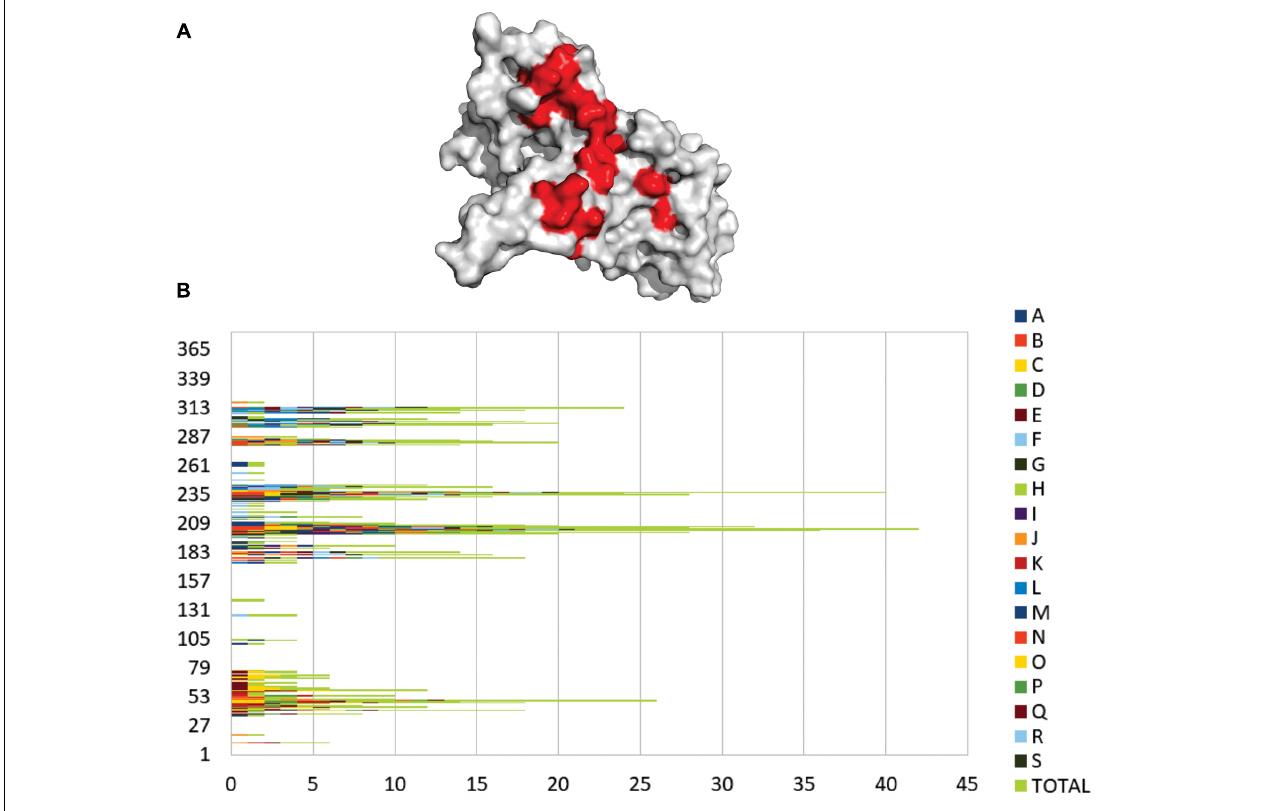
FIGURE 6 | Frequent contact regions of GAPDH protein-protein interaction. (A) GAPDH (gray) and its four more frequent contact regions (red) of interaction with partner proteins. (B) The graphic shows the frequency of interaction for 18 GAPDH protein partners. Each letter and color represents a different protein that interacted with GAPDH in silico and the green bars represent the overall of the interactions in each